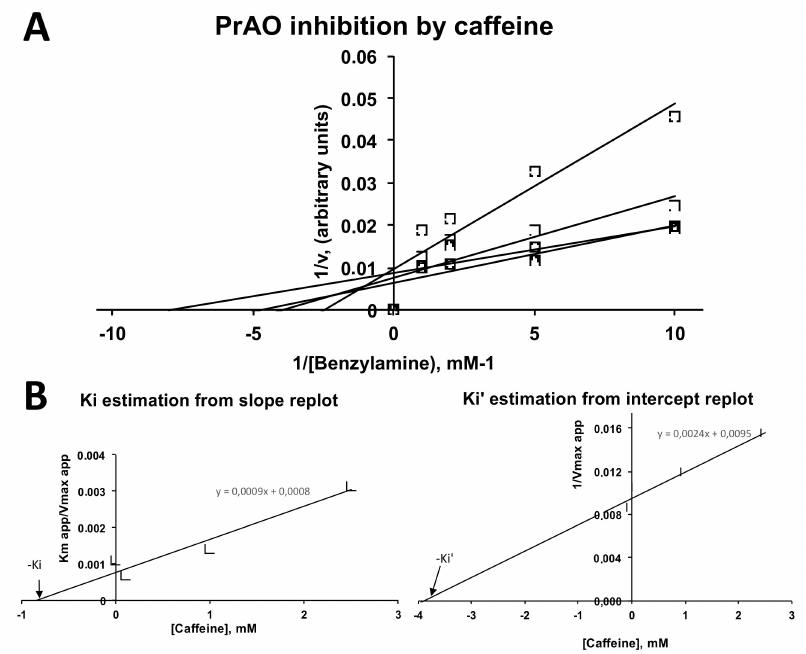
Figure 7. Caffeine inhibits PrAO in human adipose tissue. ( A ) Lineweaver–Burk plot of the inhibition of benzylamine oxidation by increasing doses of caffeine at 0.1, 1.0, and 2.5 mM. Each point is the mean of four to 10 determinations of hydrogen peroxide release over 30 min by homogenates of subcutaneous adipose tissue. ( B ) Replots from the slopes (left, Ki) or the intercepts (right, Ki’) of the double reciprocal